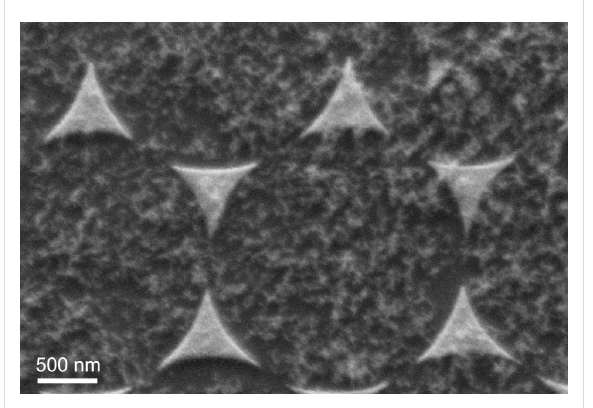
Figure 9: SEM image of Ag nanoantennas from the nanosphere lithog- raphy process (using colloid spheres with 3 μ m diameter), covered with TiO 2 :Eu